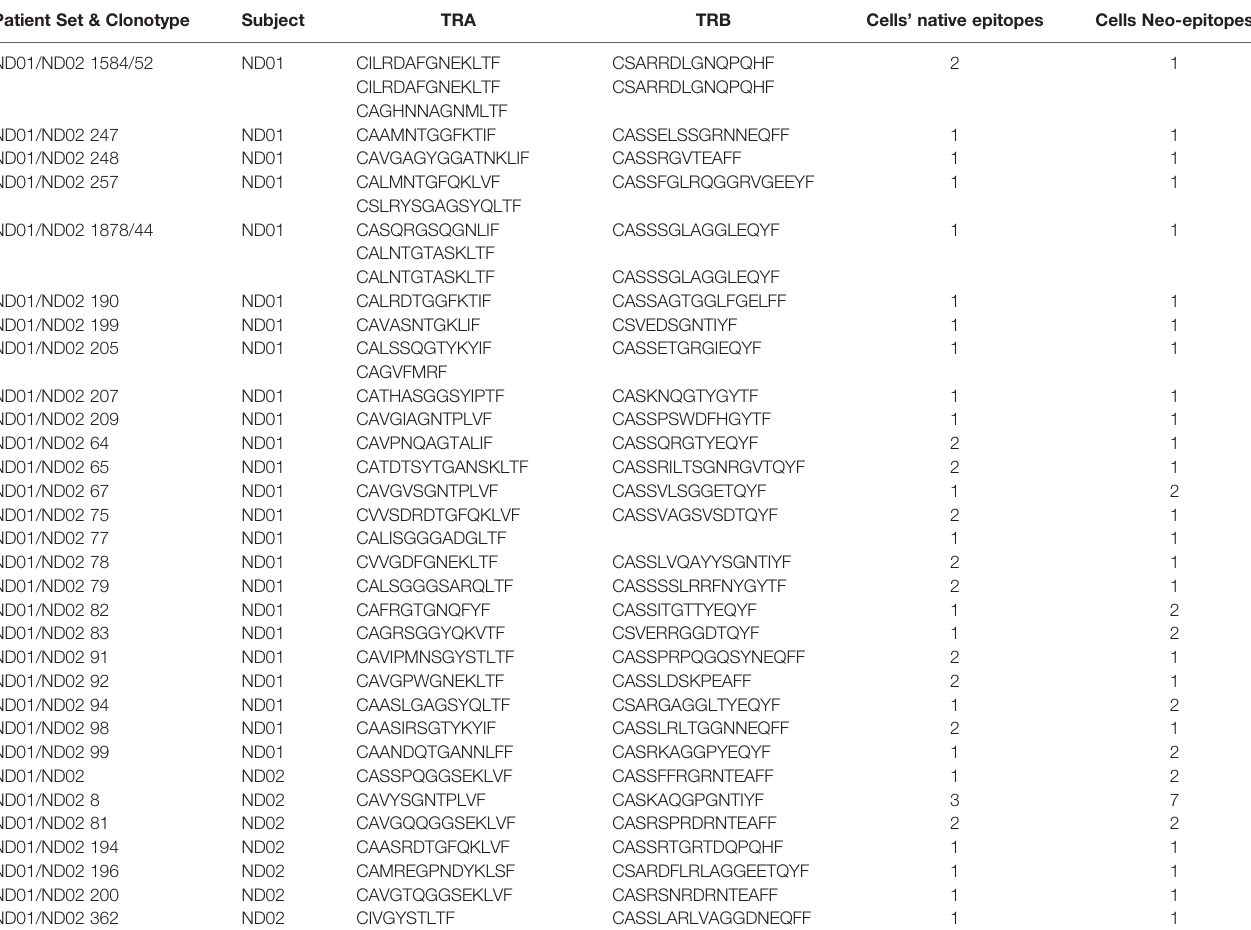
Sequences highlighted in red correspond to those listed in the JDRF npod TCR